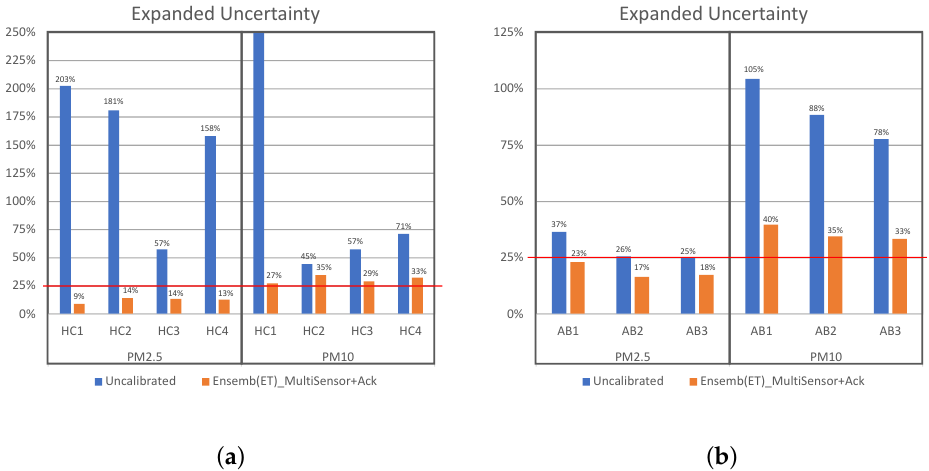
Figure 12. Expanded uncertainty of the original test measurements and of the data corrected by our best calibration models (Ensemb(ET)_MultiSensor+Ack) of the different IQAir and AirBeam sensors. The red line indicates the quality objective of 25% of expanded uncertainty to be considered as equivalent measurement for the monitoring of PM, according to Directive 2008/50/EC of the Euro- pean Commission; 50% of expanded uncertainty is the quality objective for indicative measurements; ( a ) IQAir; ( b )